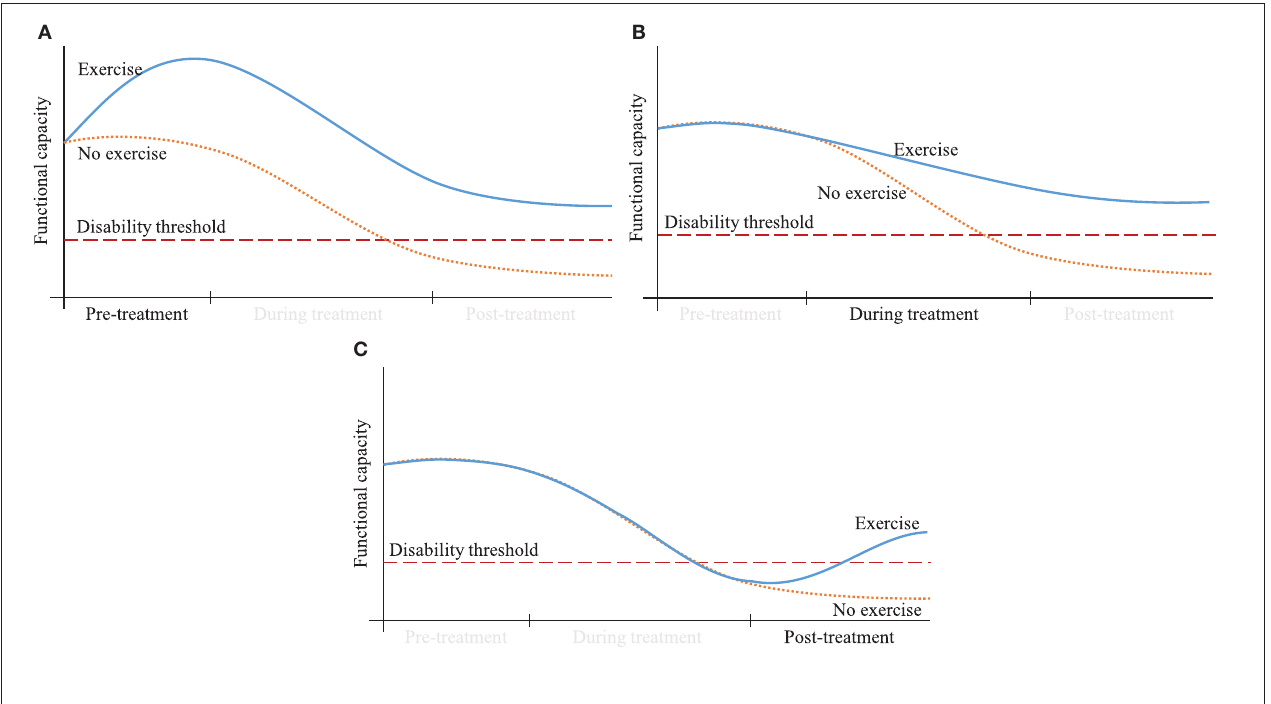
FIGURE 3 | Theoretical representation of how an exercise strategy implemented either at (A) pre, (B) during, or (C) post-treatment could improve a survivor’s functional